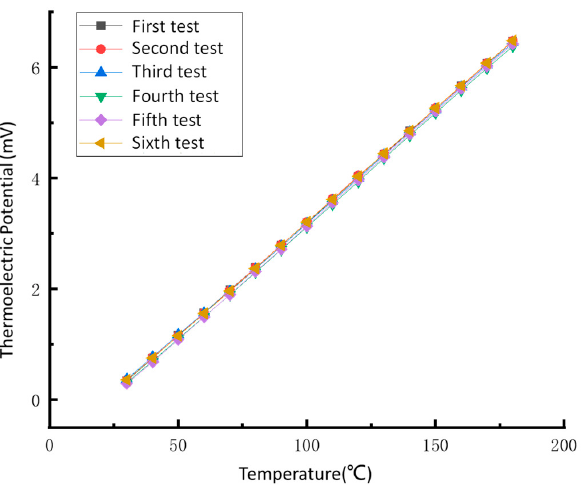
Figure 12. Repeatability calibration curve of thin-film thermocouple temperature sensors.